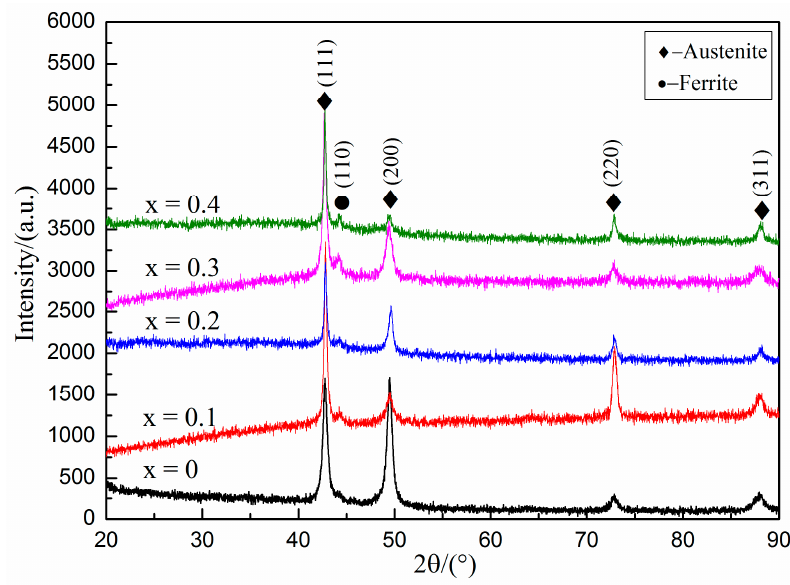
Figure 2. XRD diffraction pattern of Fe-25Mn-9Al-8Ni-C-xTi alloy. The microstructure of the Fe-25Mn-9Al-8Ni-1C-xTi alloy is present in Figure 3, and